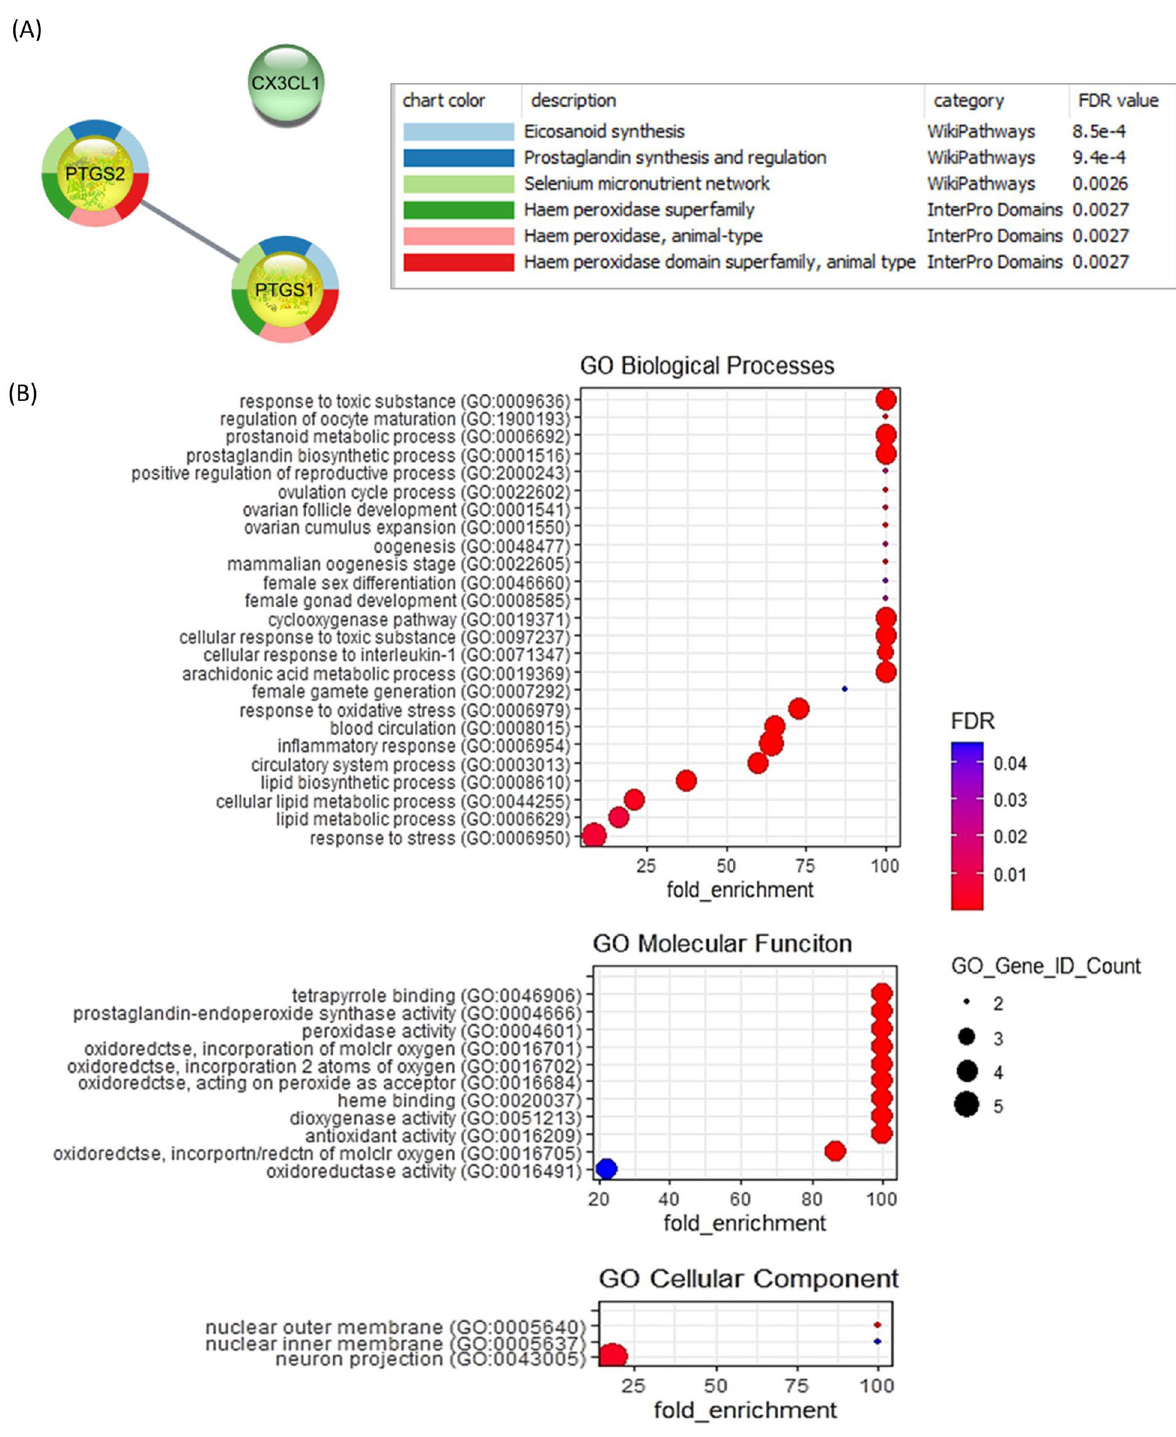
Figure 4. Gene enrichment analysis for 3 significantly downregulated genes (PTGS1, PTGS2 and CX3CL1) in bovine endometrial cells after incubation with HF-EXO compared to the control ( A ) STRING protein n-protein interaction (PPI) analysis ( B ) Gene ontology (GO) enrichment for biological processes, molecular function and cellular component revealed highest enriched GO terms relate to reproduction and inflammation. Fisher’s exact test was used for GO annotations. The corrected P-value was calculated to false discovery rate (FDR), FDR <